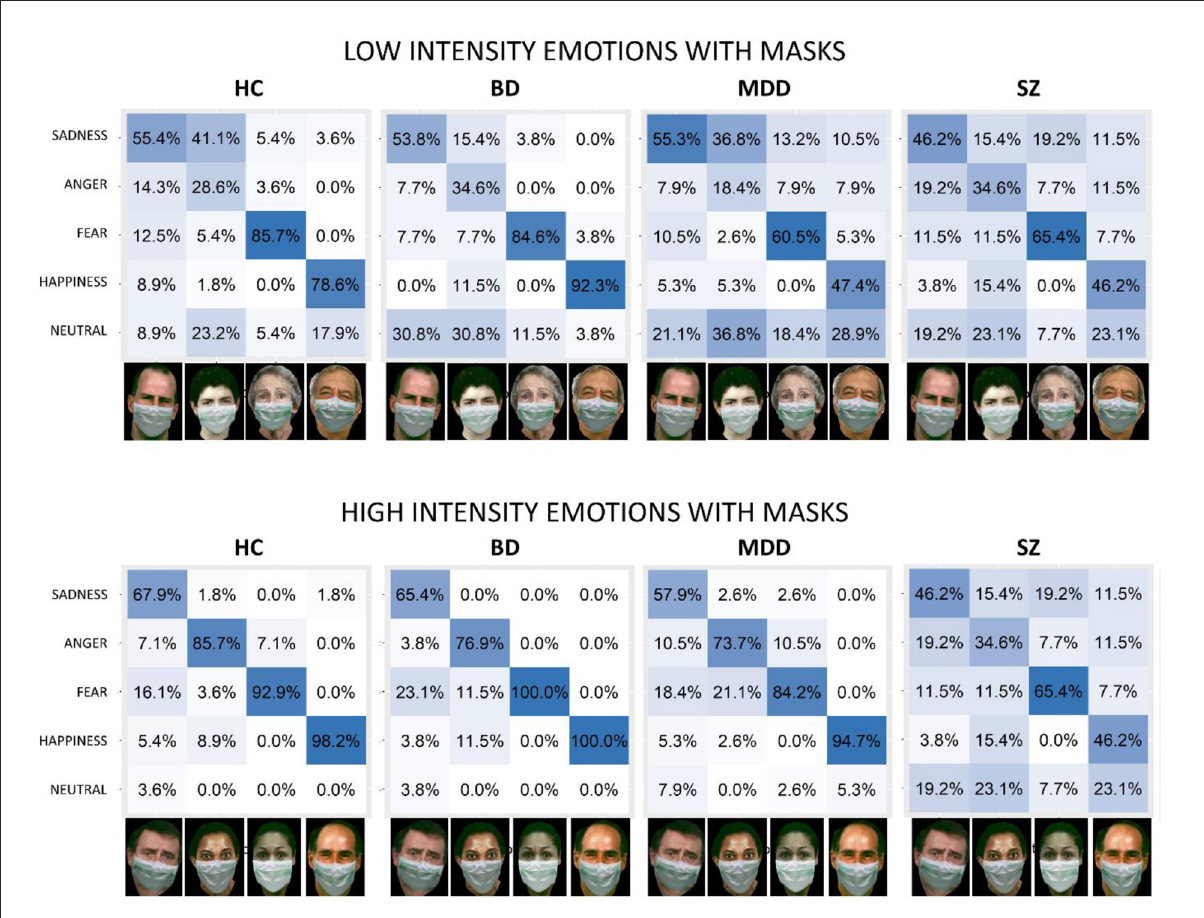
FIGURE4 Confusion matrices for emotion inference from low-intensity (bottom) and high-intensity (top) facial configurations with face masks for all groups. The x-axis shows the presented stimuli. The y-axis shows the emotions perceived by participants. Columns report the percentage of responses for each emotion. HC, healthy control; BD, patients with bipolar disorder; MDD, patients with major depressive disorder; SZ, patients with schizophrenia. Face images were obtained with permission from the ER-40 color emotional stimuli public database (30, 31).